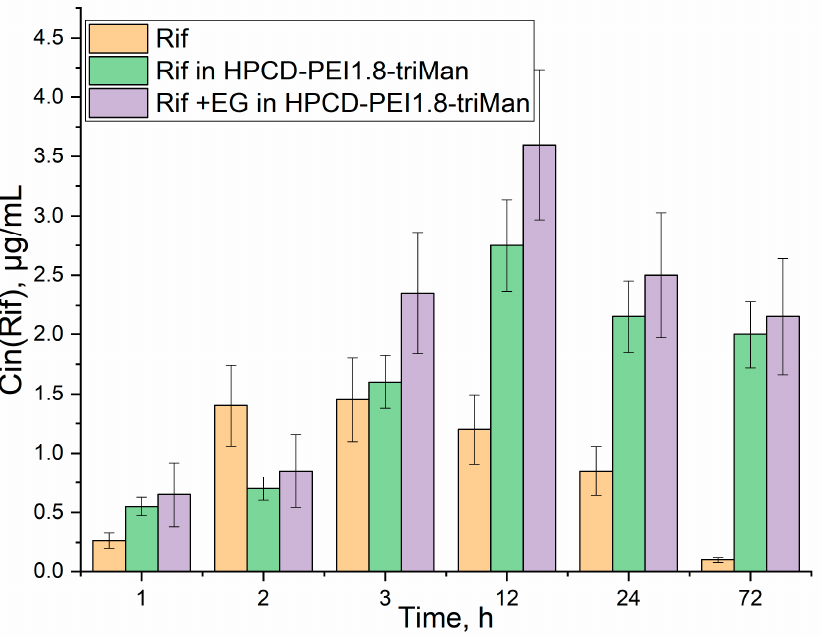
Figure 3. Intracellular ( E. coli ) concentrations of Rif pre-incubated with cells in the form of various formulations: free form, in the delivery system, and enhanced with the adjuvant (EG).